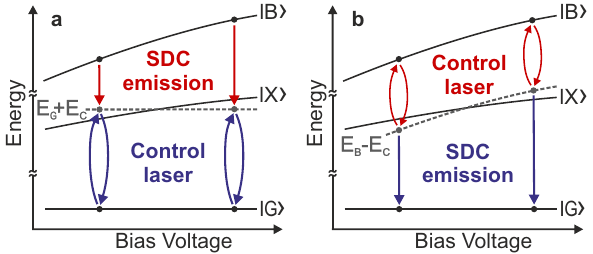
Fig. 1 Excitation and down-conversion scheme. Two-photon excitation from the ground state j G i to the biexciton state j B i and stimulated down- conversion (SDC) to a virtual state by a control laser- fi eld. The energy of the spontaneous SDC emission is de fi ned by the energies of the state j B i and the control-laser energy and detuned from the cascaded decay via the exciton state j X i .